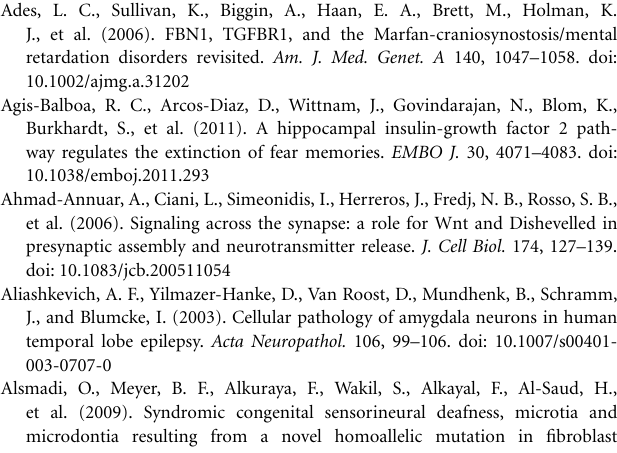
presynaptic or postsynaptic cell. Abbreviations used: β -cat, β -catenin; BDNF, brain-derived neurotrophic factor; CaM, calmodulin; CaMKII, calmodulin-dependent kinase II; CREB, calcium response element binding protein; ER, endoplasmic reticulum; ERK, extracellular signal-regulated kinase; FGF, fibroblast growth factor; GSK3 β , glycogen synthase kinase 3 β ; IGF, insulin-like growth factor; IP3, inositol 1,4,5-trisphosphate; MAPK, mitogen-activated protein kinase; PI3K, phosphatidylinositide 3-kinase; PLC, phospholipase C; TrkB, tyrosine receptor kinase B; VGCC, voltage-gated calcium